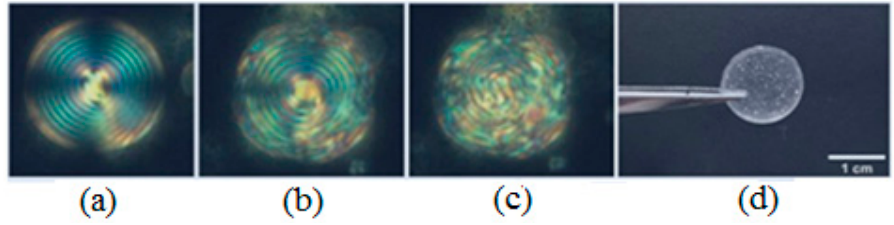
Figure 17. ( a – c ) Microsphere texture degradation. Reprinted with permission from ref. [37]. Copy- right 2021, Wiley-VCH GmbH. ( d ) Free-standing PDMS film containing chromonic microspheres. Reprinted from [49].